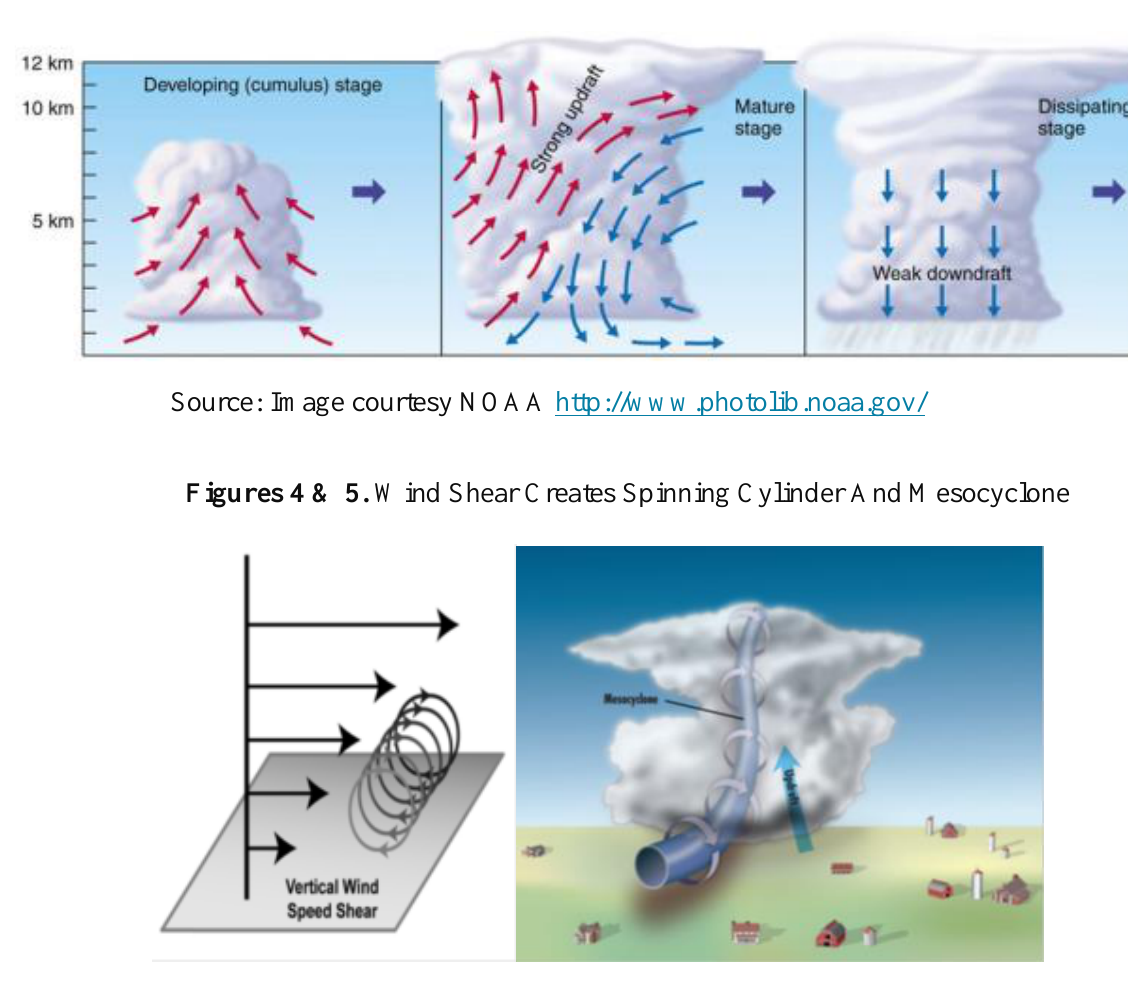
Figure 3. Three Stages Of Thunderstorm